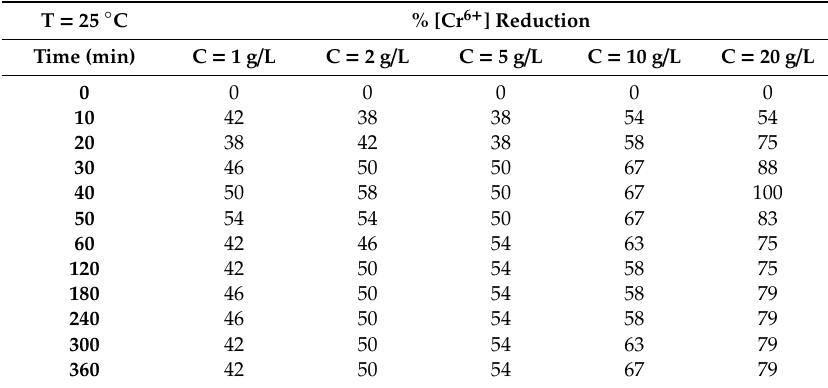
Table 2. Chromium removal percentage vs time (10 min for the first treatment hour) at T = 25 ◦ C and pH = 5.5 for the ratios: (i) 2:1 g / L, (ii) 2:2 g / L, (iii) 2:5 g / L, (iv) 2:10 g / L and (v) 2:20 g / L potassium dichromate:zeolite X. T = 25 ◦